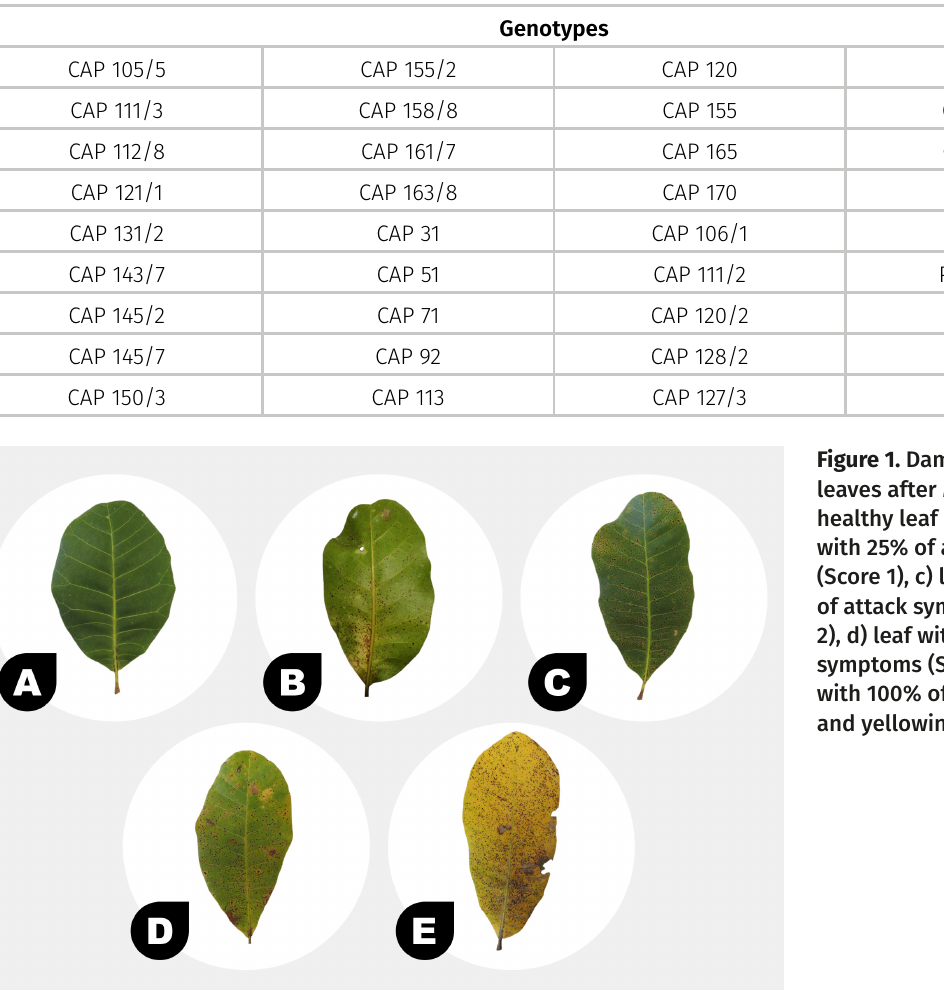
Table I. Dwarf cashew genotypes evaluated in the Experimental Field of Pacajus, State of Ceará, Brazil, 2015-2016. Genotypes